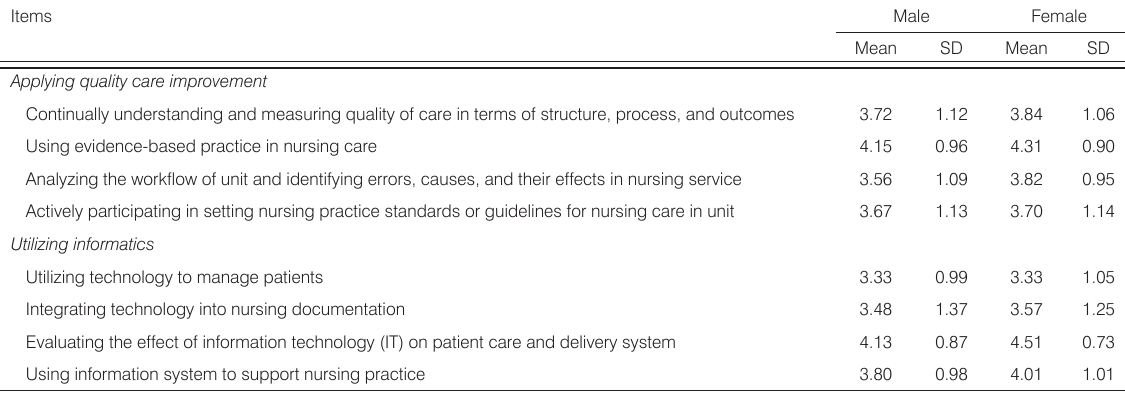
Table 1. Managerial competence according to gender ( N =